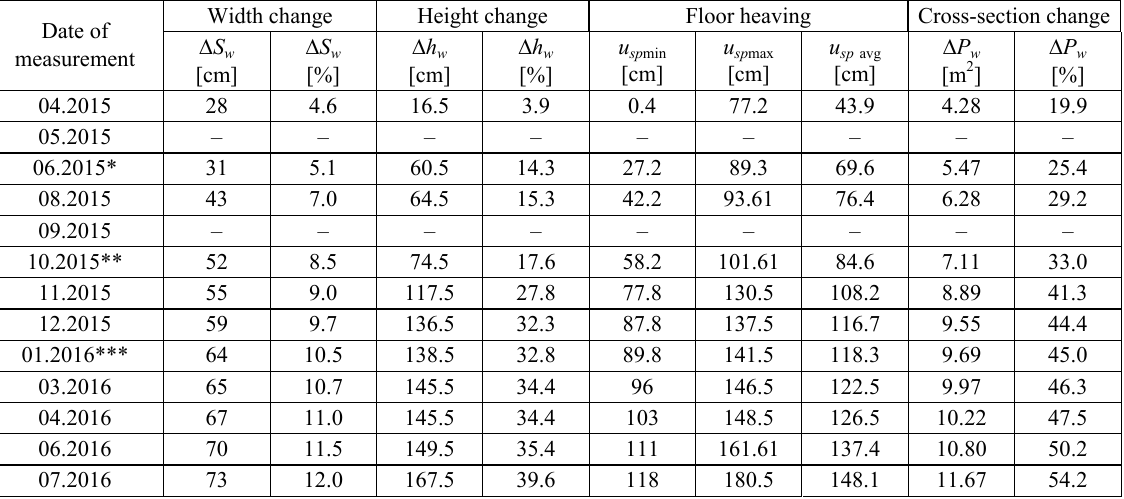
Fig. 4. Maingate D-2 convergence – base on 790 m (  S – roadway width change,  h – roadway height change, u st – roof displacement, u sp –floor heaving) Table 4. Maingate D-2 convergence – base on 757